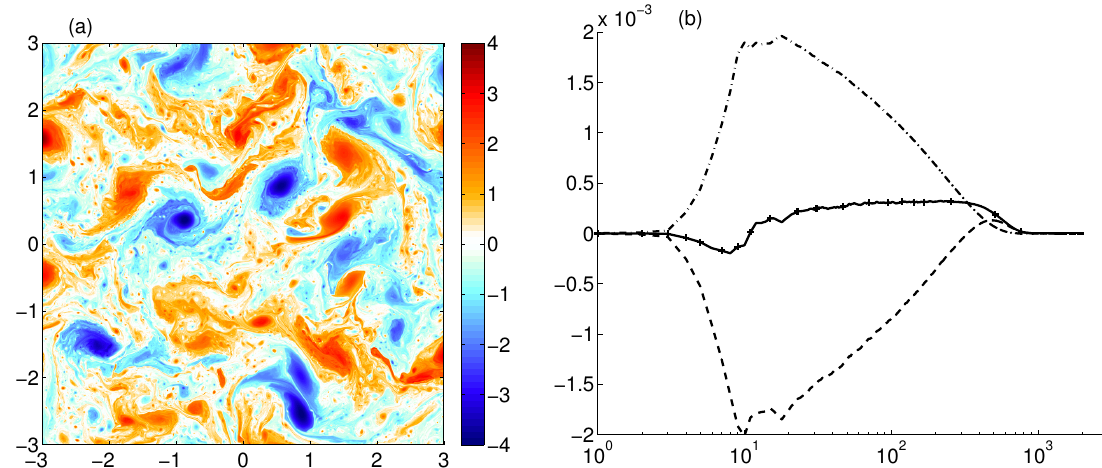
Figure 2. ( a ) Surface buoyancy in a freely-decaying simulation at a resolution of 1024 × 1024. Note that the vortices at all scales develop from filament instability. ( b ) Spectral fluxes Π θ (continuous curve), Π u (dashed curve) and Π a (dash and dotted curve). See the text for the definition. Panel (b) is from [50], with permission of Cambridge University